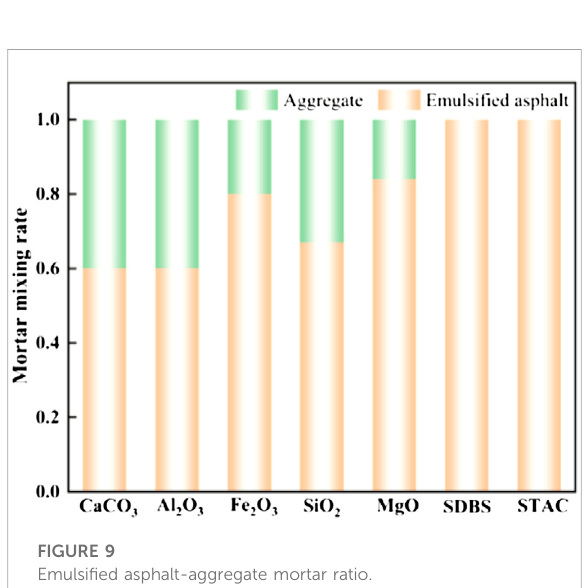
FIGURE 8 Premature demulsi fi cation of the emulsi fi ed asphalt mortar results.